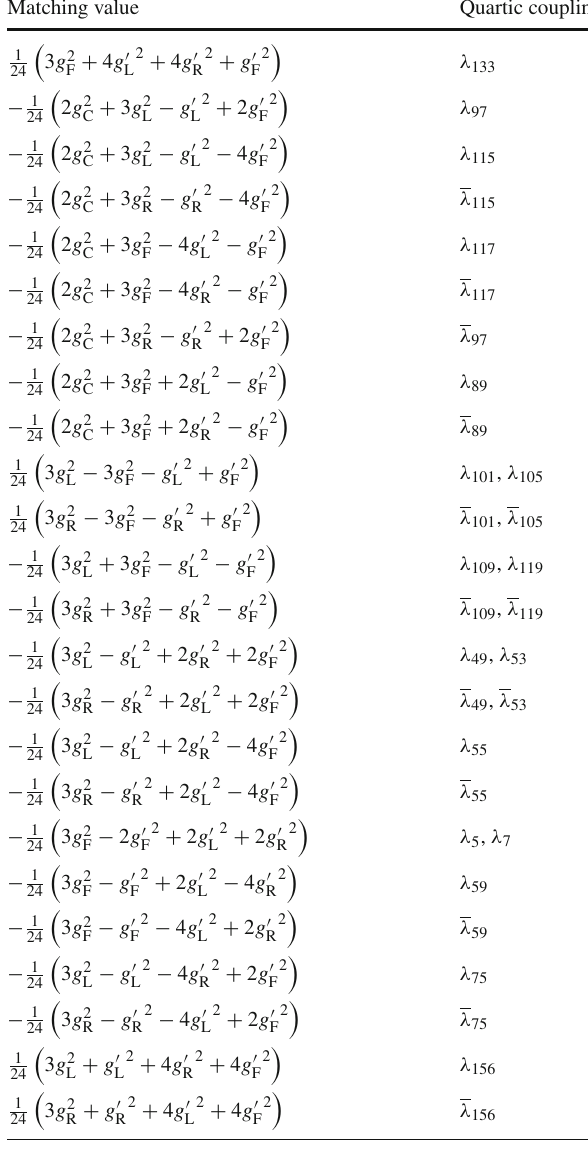
Table 13 Scalar quartic couplings matching conditions with four D- term interactions. The λ i couplings refer to the ( L → R ) part of V 4 Matching value Quartic